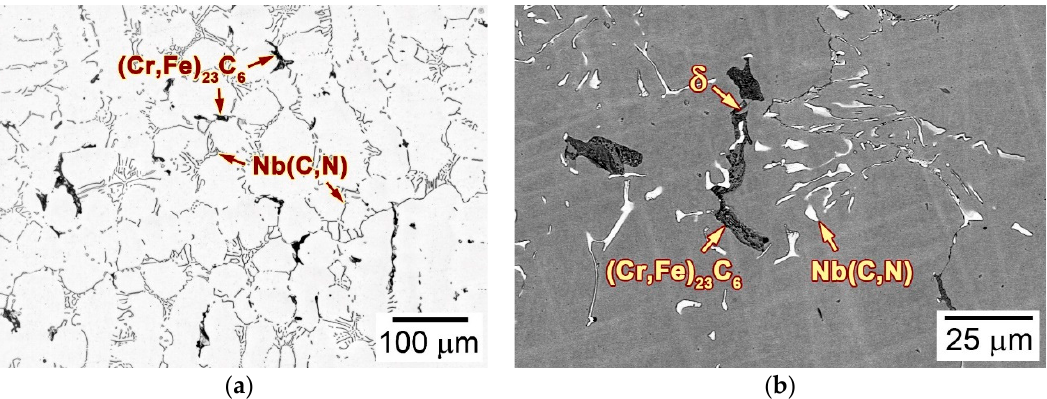
Figure 4. ( a ) Optical and ( b ) scanning electron microscope-backscattered electron (SEM-BSE) images showing the microstructure of as-cast alloy 3C2N.